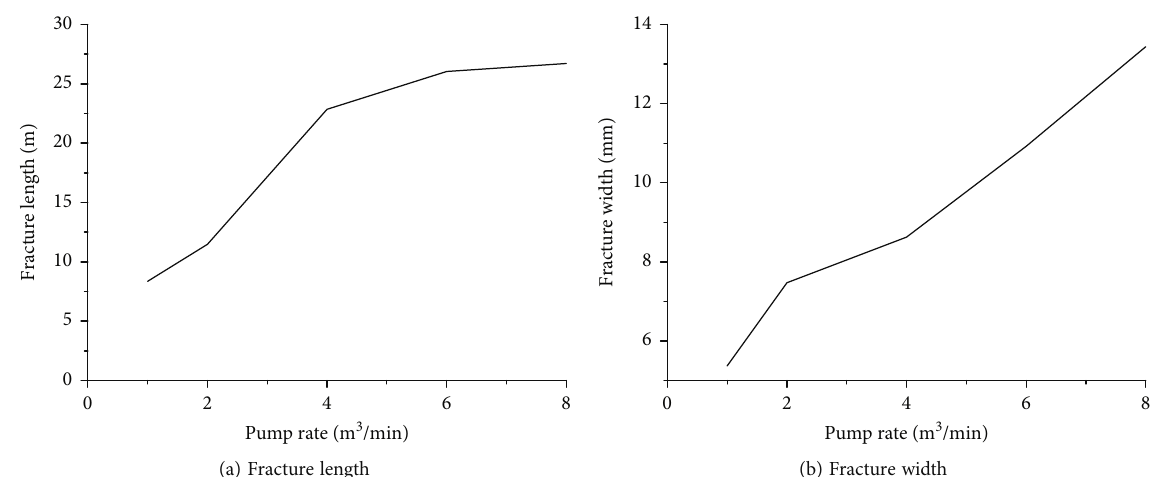
Figure 16: Fracture length and width at the NF approaching angle of 30 ° and at injection rates from 1-8m 3 /min.